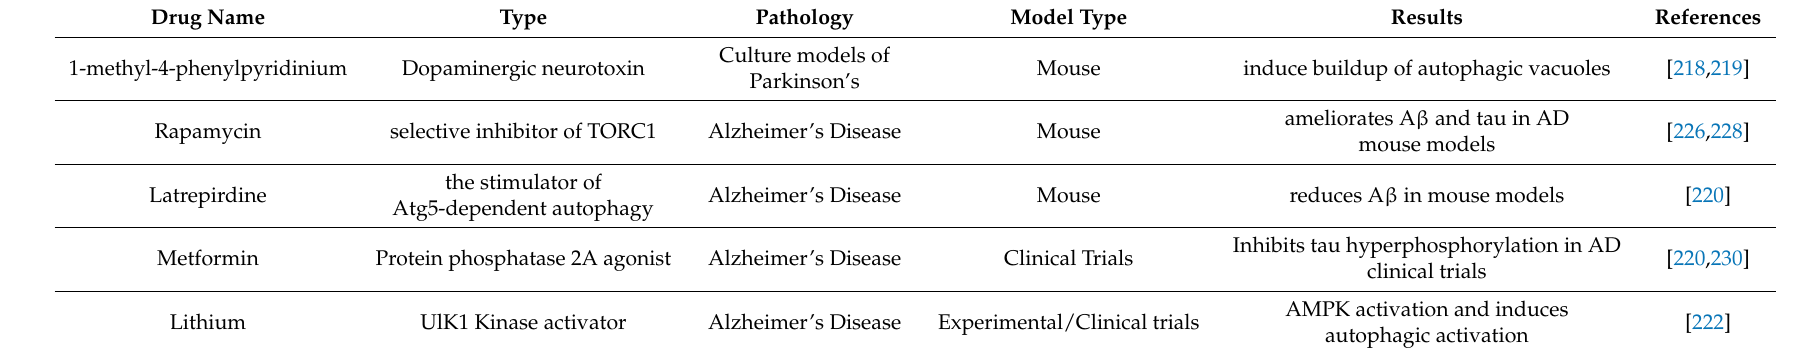
Table 3. Summary of pharmacological agents enhancing